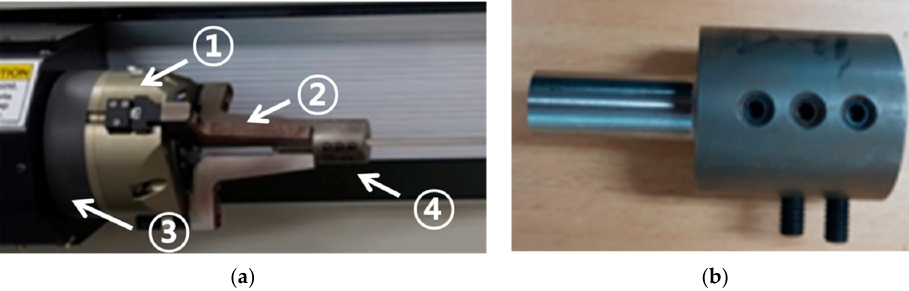
Figure 7. Images of feeding and rotation parts of the CNC bending machine: ( a ) image of the feeding and rotation assembly, composed of the (1) rotation module, (2) set of clamps, (3) feeding module, and (4) Nuss bar jig; ( b ) image of the customized jig tool for Nuss bar processing.